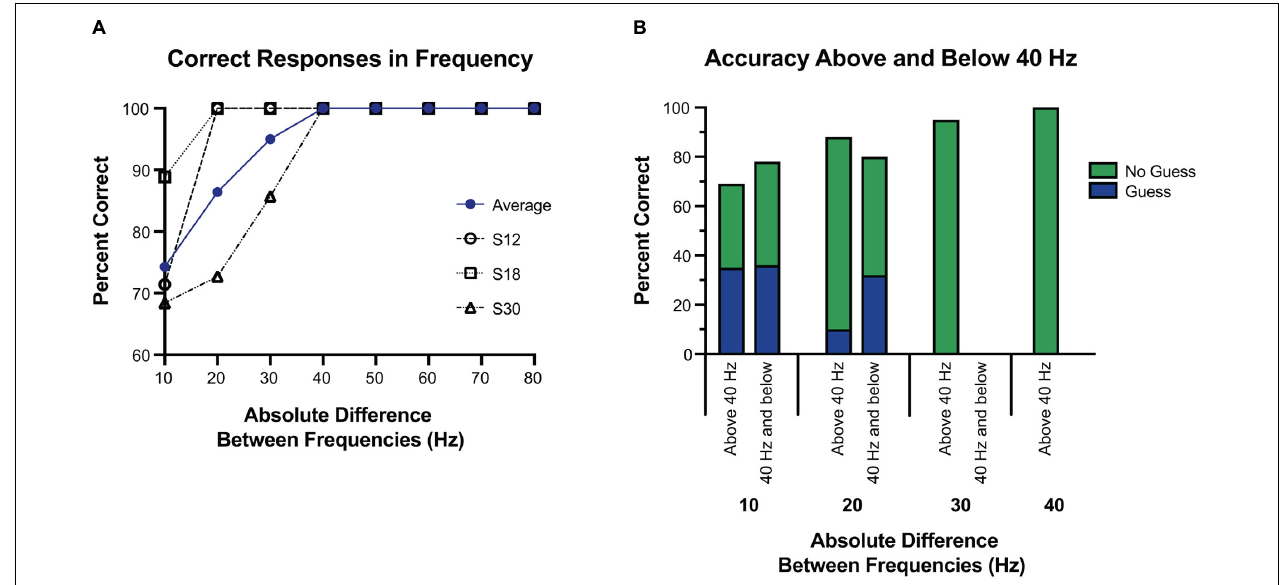
FIGURE 5 | Accuracy at tested frequency differences. (A) Overall accuracy for each subject, at each frequency difference. The average of their results is in blue. Above a 30 Hz difference, accuracy was 100%, and well above chance at or below 30 Hz. (B) Response accuracy and guessing rate when the tested frequencies were both 40 Hz and below vs. when one or more of the tested frequencies was above 40 Hz. Here the blue and green represent which portions of correct responses were self-reported as a guess, or not a guess, respectively. Overall, subjects were equally accurate regardless of whether the frequencies were above or below 40 Hz, and were more likely to guess if the difference was 10